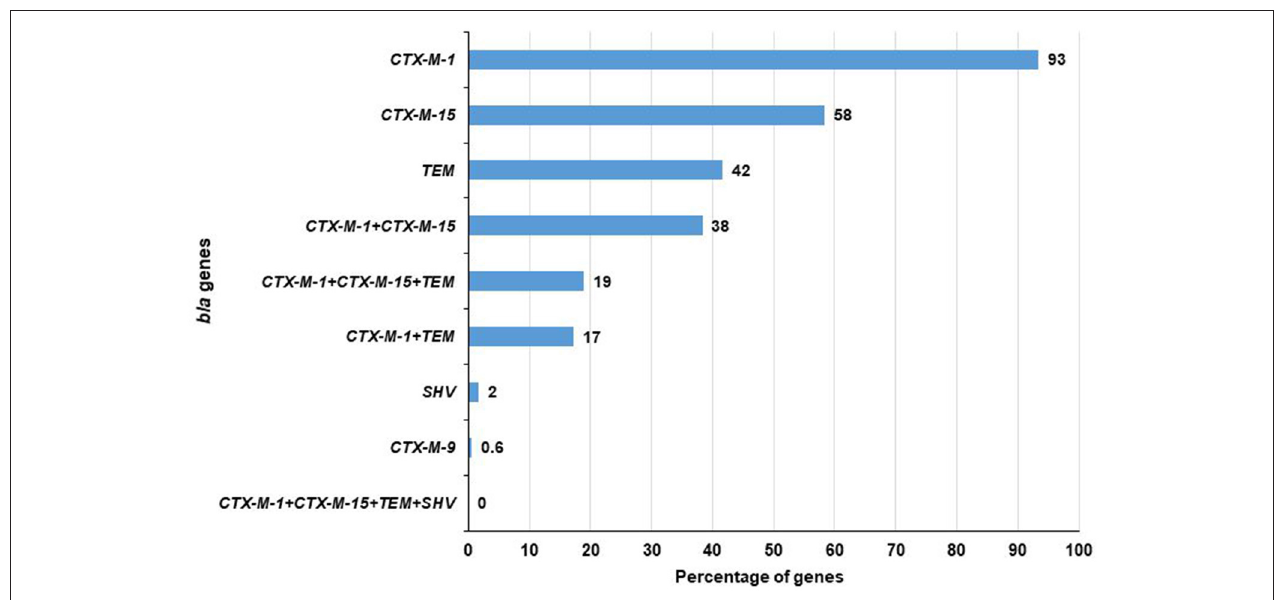
FIGURE 2 | Prevalence of different bla genes in ESBL producing E. coli